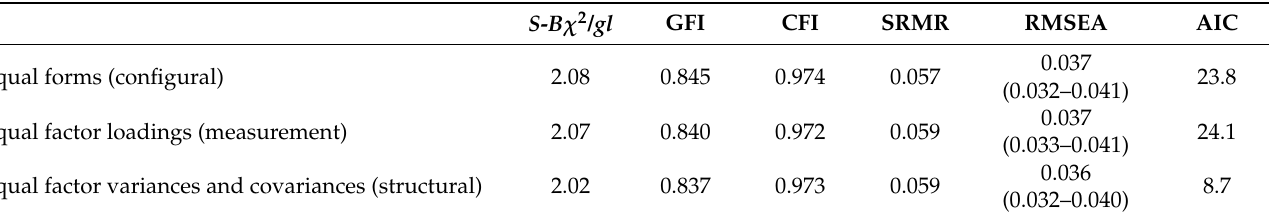
Table 5. Confirmatory factor analysis: goodness-of-fit indices for multigroup gender invariance of Model 1 ( N =